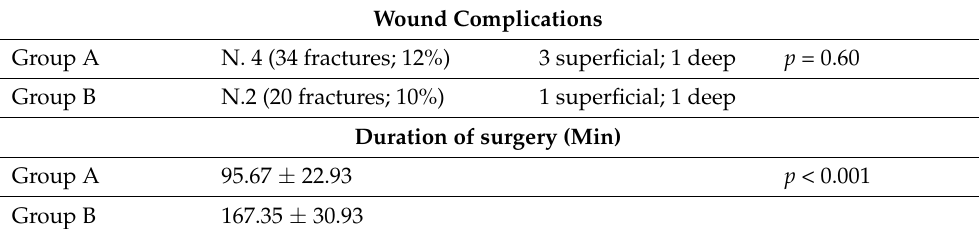
Table 4. Results. Table 4.